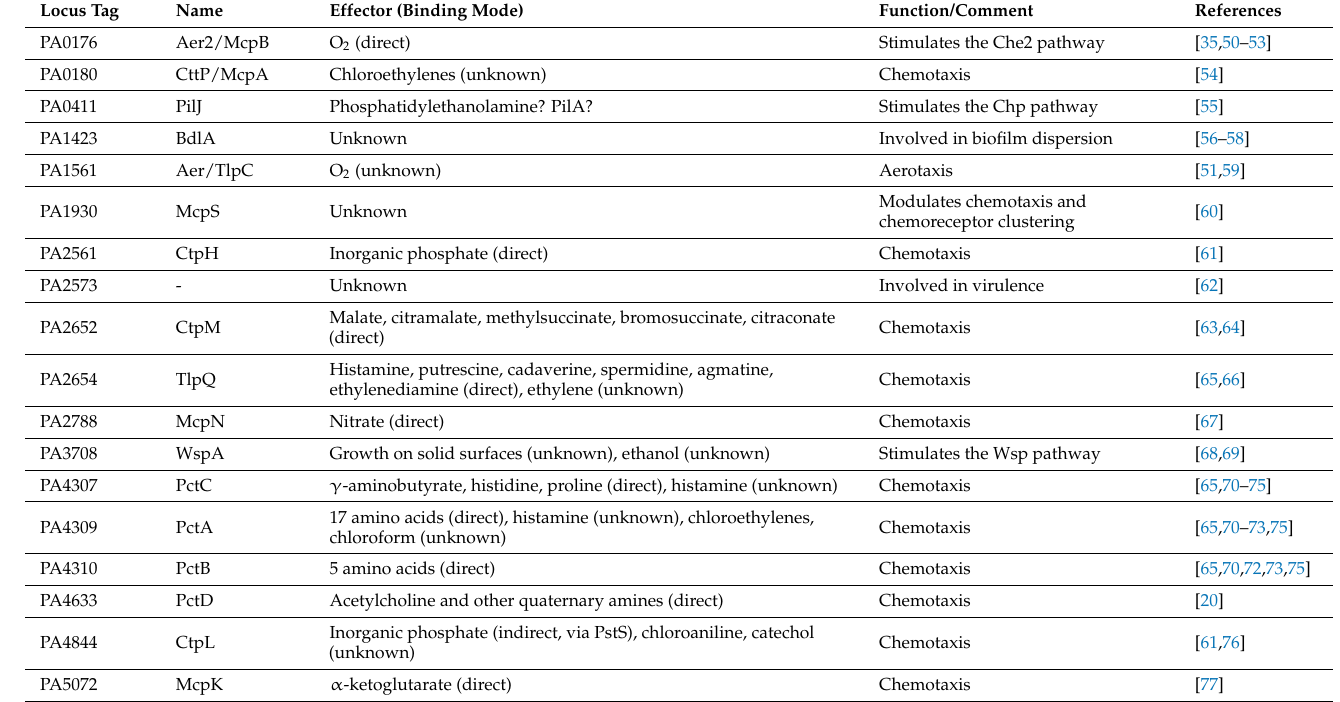
Table 1. P. aeruginosa PAO1 chemoreceptors for which information is available on function and/or signal